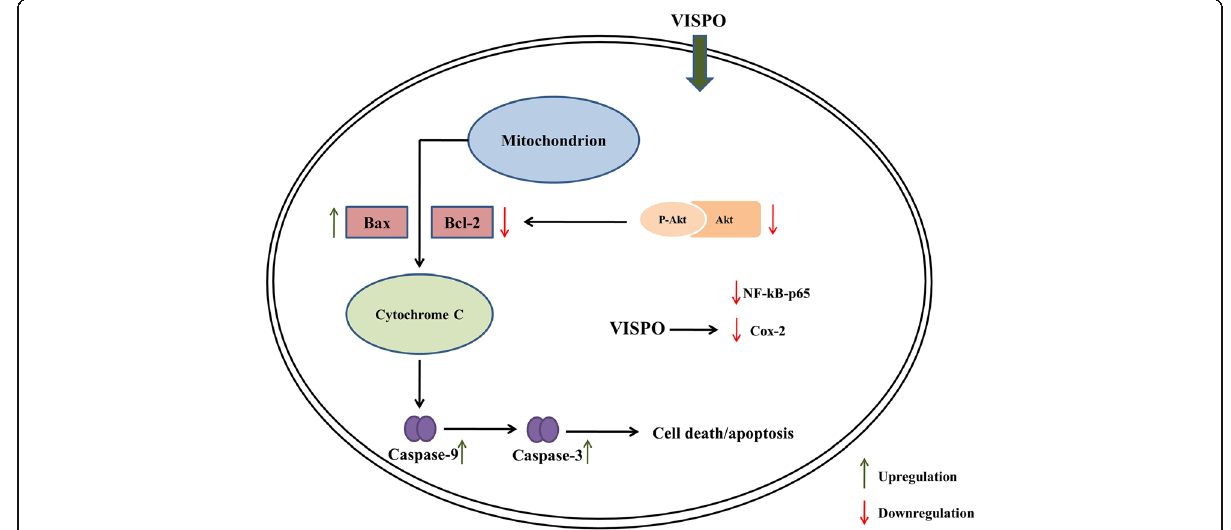
Fig. 8 Schematic representation of the proposed mechanism for the efficacy of VISPO in BPH model